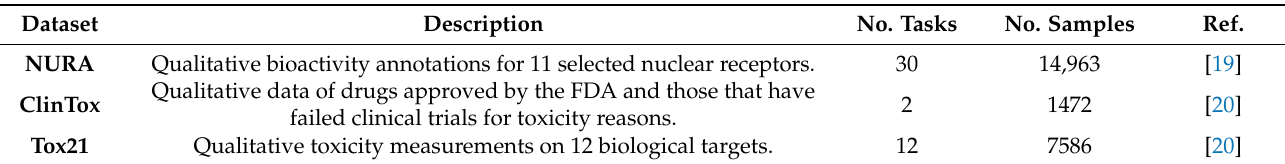
Table 3. Summary information of the considered multitask datasets. Dataset Description No. Tasks Qualitative data of drugs approved by the FDA and those that have failed clinical trials for toxicity